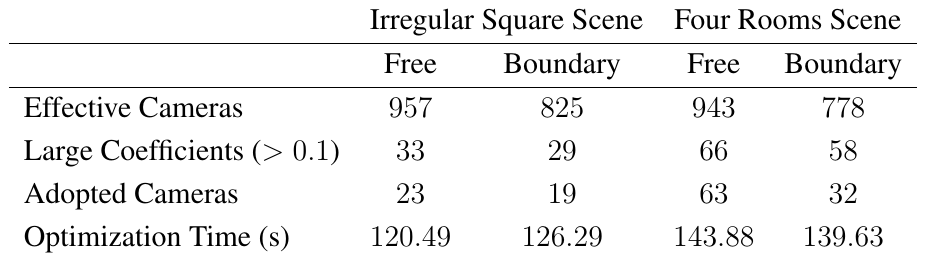
Table 3. Experimental data of layout optimization in two scenes with critical regions.